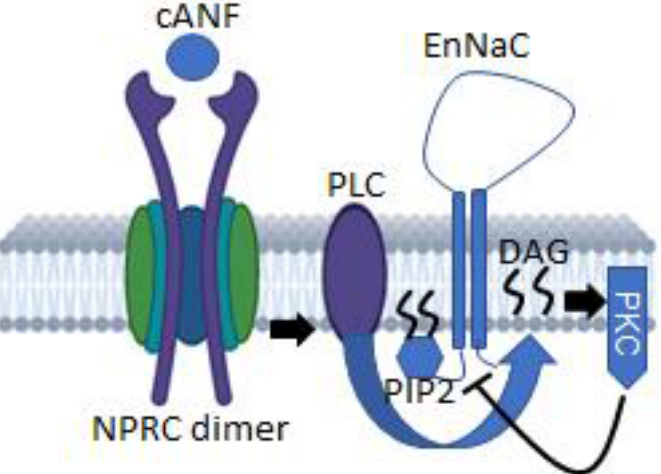
Figure 7. Schematic of the proposed model for the inhibition of EnNaC following NPRC activation. NPRC is activated by ligand binding. The NPRC agonist cANF is shown to selectively bind to NPRC. NPRC ligand biding results in the activation of phospholipase C (PLC) leading to the hydrolysis of PIP2. Hydrolysis of PIP2 produces the hydrophobic molecule diacylglycerol (DAG) which is retained in the plasma membrane and activates protein kinase C (PKC). PKC is known to inhibit the activity of ion channels including epithelial sodium channels (ENaC) and presumably endothelial sodium channels (EnNaC). Schematic was created in part using the BioRender software.